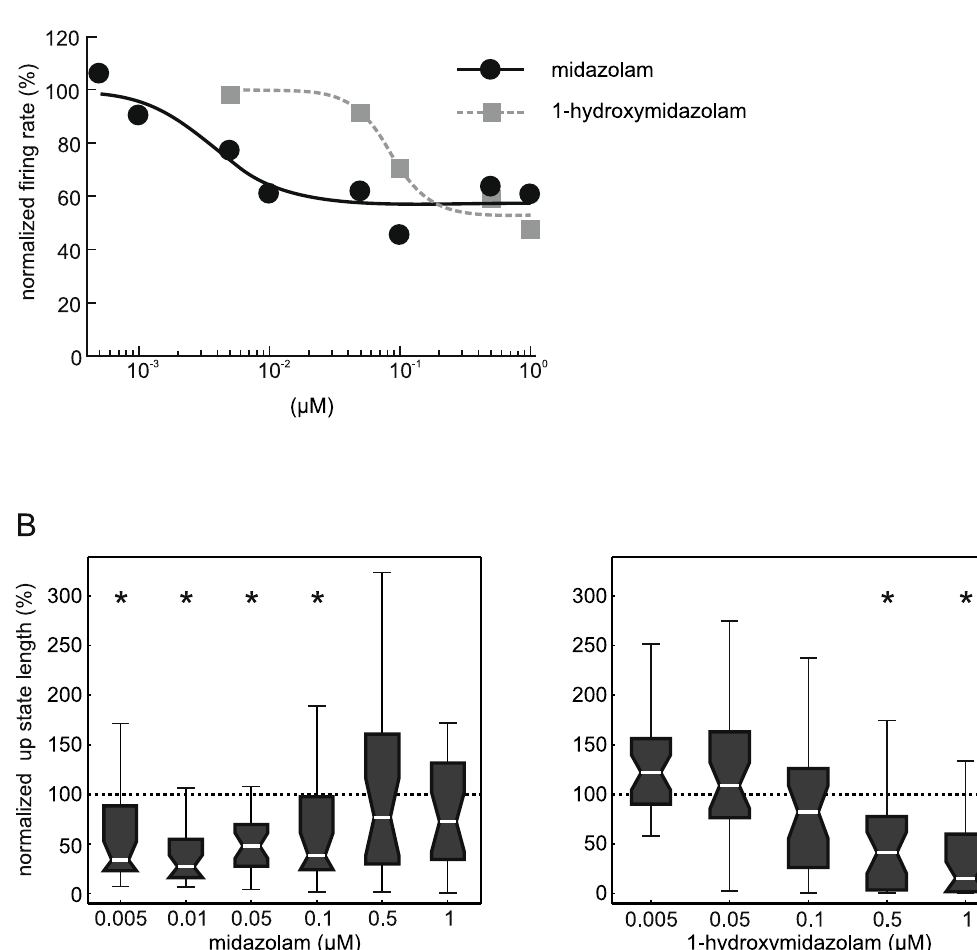
Figure 4. Comparison of the effects of midazolam and 1-hydroxymidazolam in neocortical slice cultures from wild-type mice. ( A ) Combined presentation of the effect of midazolam (black, taken from Fig. 1A) and 1-hydroxymidazolam (grey, taken from Fig. 2A) on the normalized action potential firing rate for comparison of actions. Data were fit as described in the methods section. Measures of statistical dispersion have been omitted for clarity reasons. Note that the two curves are shifted by roughly one order of magnitude. ( B ) Actions of midazolam and 1-hydroxymidazolam on the duration of phases of high neuronal activity (up state length). Data were also normalized to the median of the ASCF sham application (given by the dashed line). Midazolam significantly reduced the up state length between 5 nM and 100 nM. However, this effect was absent at 500 nM and 1 μ M midazolam ( * p < 0.001; Kruskal-Wallis test, post-hoc analysis (Bonferroni)). In comparison, 1-hydroxymidazolam significantly shortened the up state length starting at 500 nM (Kruskal-Wallis test, post- hoc analysis